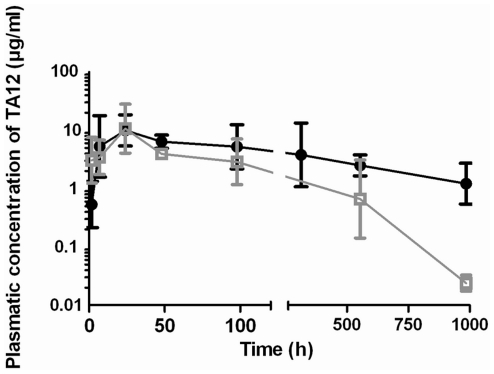
Pharmacokinetic analysis of cTA12 and mTA12 in mice.50 µg of purified antibody was intraperitoneally injected into Swiss mice (n = 3 or 4). Mice were sacrificed at different times to calculate plasma concentrations of mAb (• mTA12;  cTA12) using a competitive immunoassay. Data were analysed and fitted with WinNonLin professional software (Pharsight®).